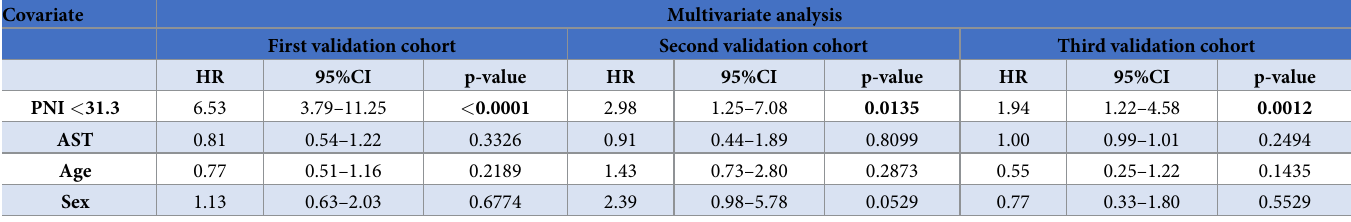
Table 4. Multivariate analysis in the first, second and third validation cohort. Covariate Multivariate